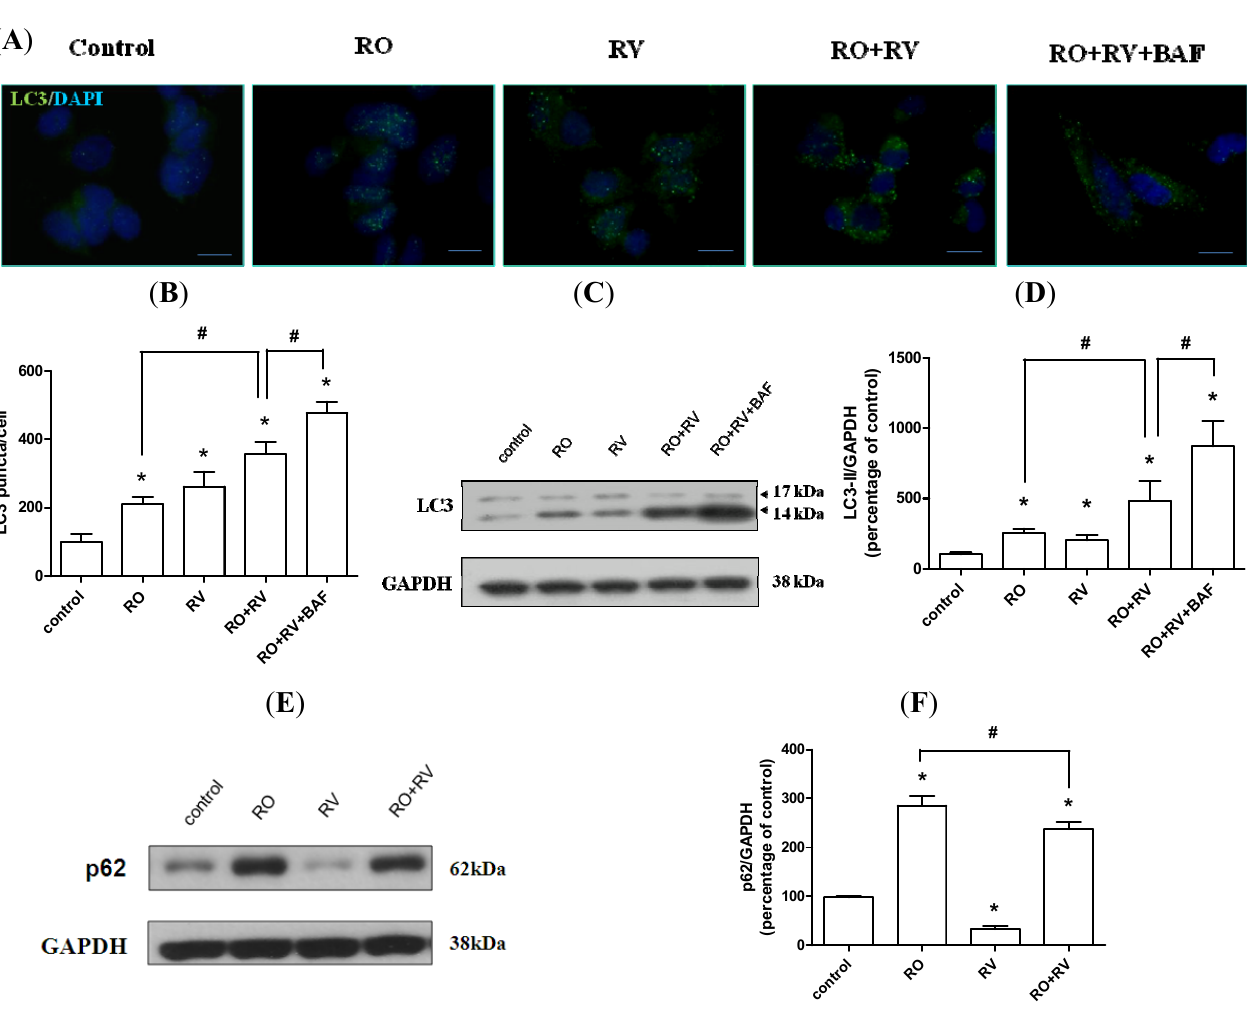
Figure 3. Resveratrol prevents rotenone-mediated inhibition of autophagy. SH-SY5Y cells were pretreated with/without 20 μ M resveratrol for 24 h, then treated with/without 20 μ M rotenone in the presence/absence of 10 nM bafilomycin A1 for the next 24 h. ( A , B ) LC3 puncta (green dots) formation was examined by fluorescence microscopy and quantified using Image J. Nuclei were observed by DAPI staining (blue). Scale bar, 10 μ m. The levels of LC3 ( C , D ) and p62 ( E , F ) were determined by immunoblotting followed by quantitative analysis using Image J. Data were normalized to glyceraldehyde-3-phosphate dehydrogenase (GADPH) levels. RO, rotenone; RV, resveratrol; BAF, bafilomycin A1. Data (mean ± SEM) are representative of at least three independent experiments. Statistical significance was determined by one-way analysis of variance followed by